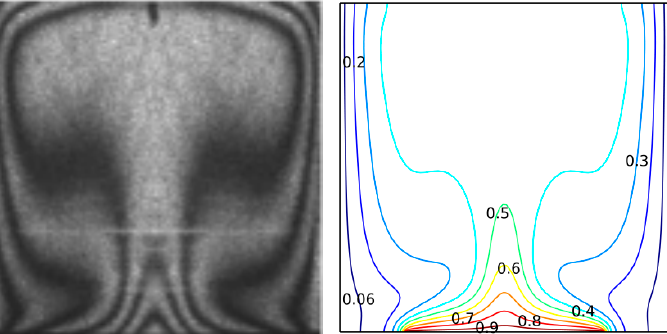
Table 2. Evaluation of the mean Nusselt number (Nu avg )and max